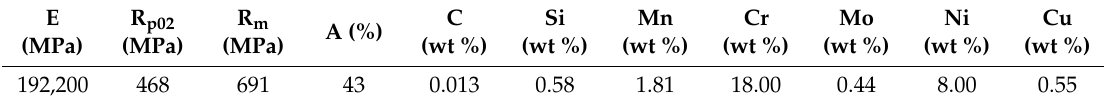
Table 1. Material properties and chemical composition of AISI 304L cold-drawn stainless steel